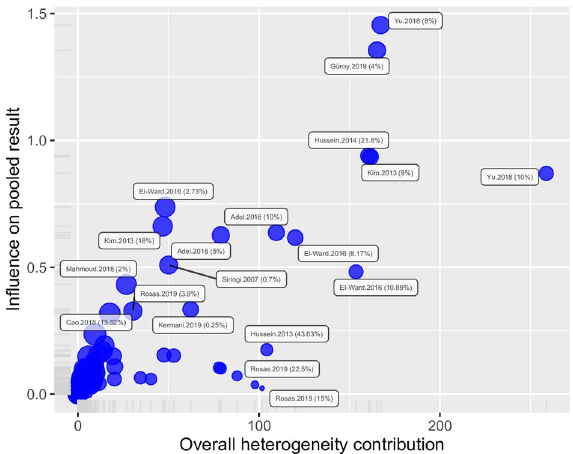
Figure 5. Baujat bubble plot used to identify potential outliers in the Spirulina data set, showing the contribution of each study to the overall heterogeneity and its influence under a random effects model. The size of each point is proportional to its relative weight in the meta-analysis. Five trials in the upper right corner accounted for a large share of the observed heterogeneity and were also overly influential which merited further scrutiny.